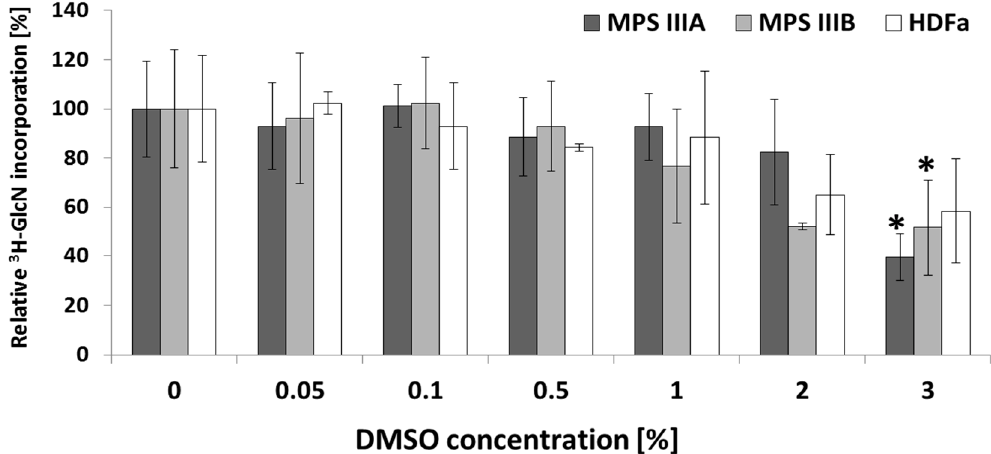
Figure 3. Kinetics of GAG synthesis upon DMSO treatment. Relative level of glycosaminoglycan synthesis in HDFa, MPS IIIA and fibroblasts after 72 h treatment with different concentrations of DMSO measured by incorporation of [3H]GlcN. Values represent means of at least two independent experiments (each run in triplicate) with bars representing standard deviation. Statistical significance was tested by Kruskal–Wallis test followed by Dunn–Bonferroni post hoc; * p < 0.05 and vs. control cells without DMSO treatment.